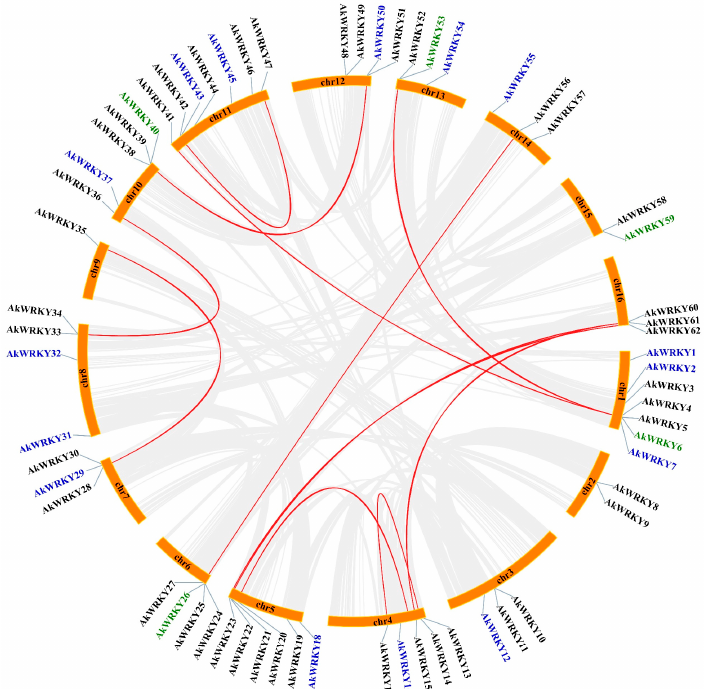
Figure 1. The chromosomal location of the WRKY genes in A. trifoliata . The red lines in the inner circle represent the gene pairs from fragment duplication. Genes marked in black are WGDs or fragment duplications, genes marked in blue are dispersed duplications, and genes marked in green are tandem duplications.